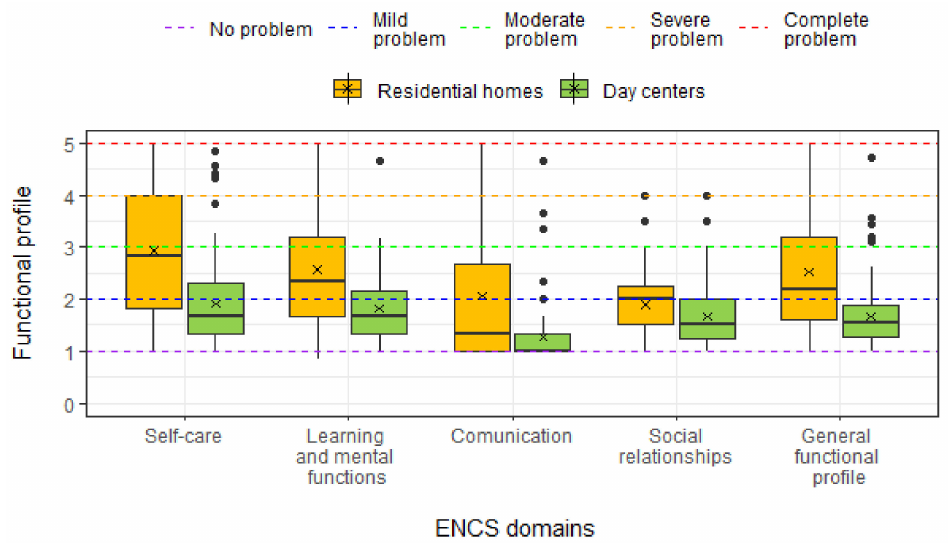
Figure 2. ENCS domain and general functional scores for two groups (RH e DC). The symbol x represents the mean and the black dots the